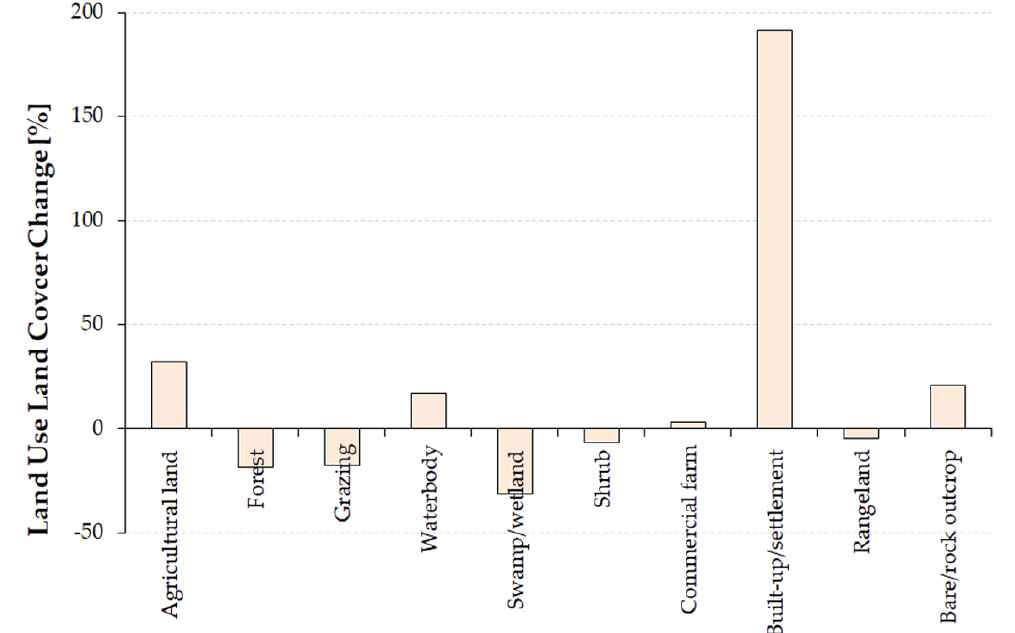
Figure 3. Land use land cover changes percentage in Ethiopia. Agricultural land use increased in all the analysed studies except in [32], while forest land use decreased in all the study cases, except for the increment pointed out by [16]. In detail, agricultural land, waterbody, commercial farm, bare/rock outcrop and built- up/settlement increased by around 32%, 17%, 3%, 21% and 191%, respectively. On the contrary, forest, grazing land, swamp/wetland, shrubland, and rangeland decreased by around 19%, 18%, 32%, 7%, and 5%, respectively (Figure